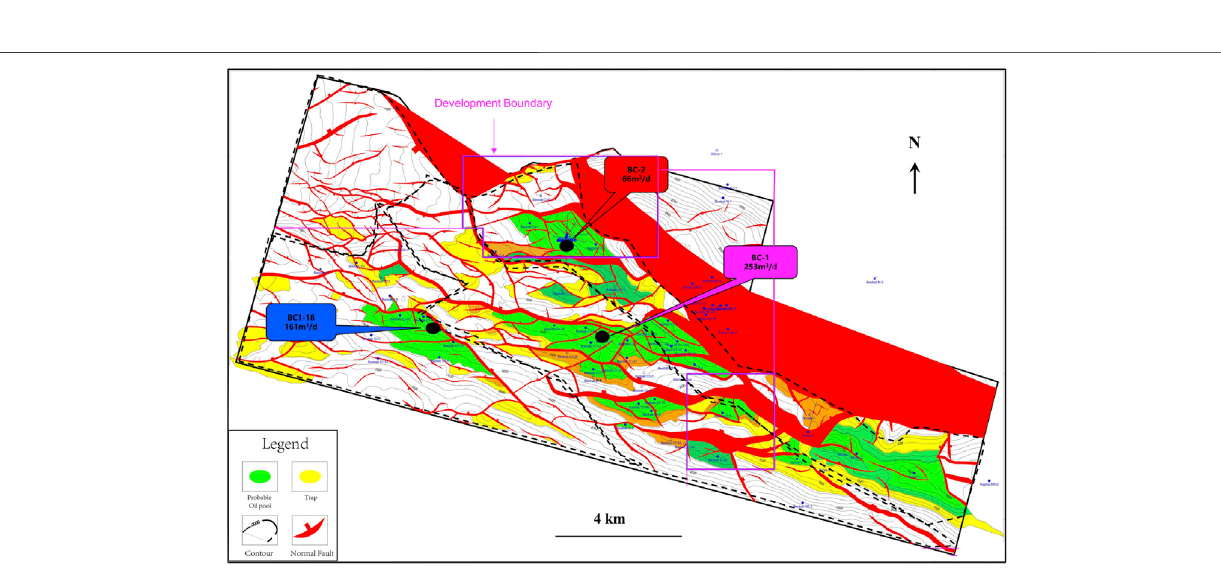
Frontiers in Earth Science |